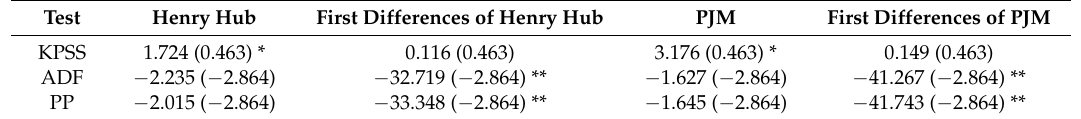
Table 2. Unit root tests.